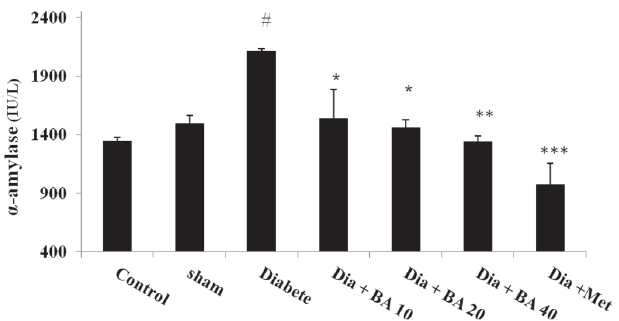
FIGURE 1 - Effect of different doses of betulinic acid on α-amylase in STZ-NA diabetic mice. Data expressed as mean ± SEM. *p<0.05, **p<0.01 and, ***p<0.001 as compared with diabetic group; #p<0.05 as compared with control and sham groups, n=10 (ANOVA and Tukey’s